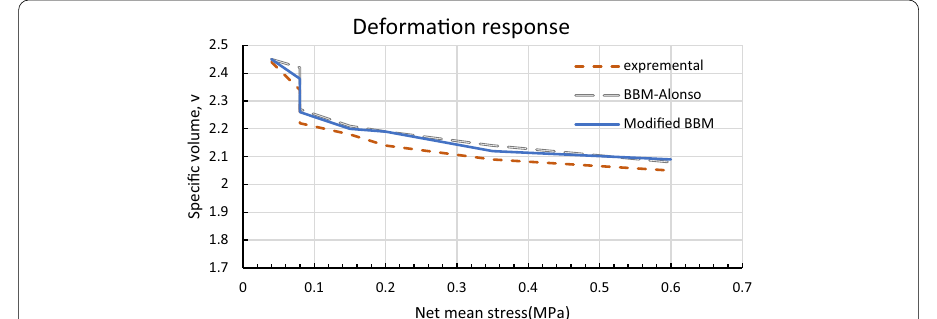
Fig. 17 Comparison among measured, predicted and modified model results for stress path AA 1 BH